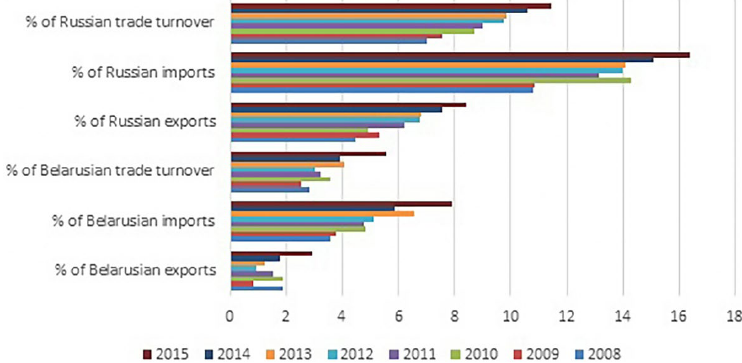
Fig. 2. China’s share of the Belarusian and Russian exports, imports and the trade volume Source : own calculation based on IMF (2011, 2015,